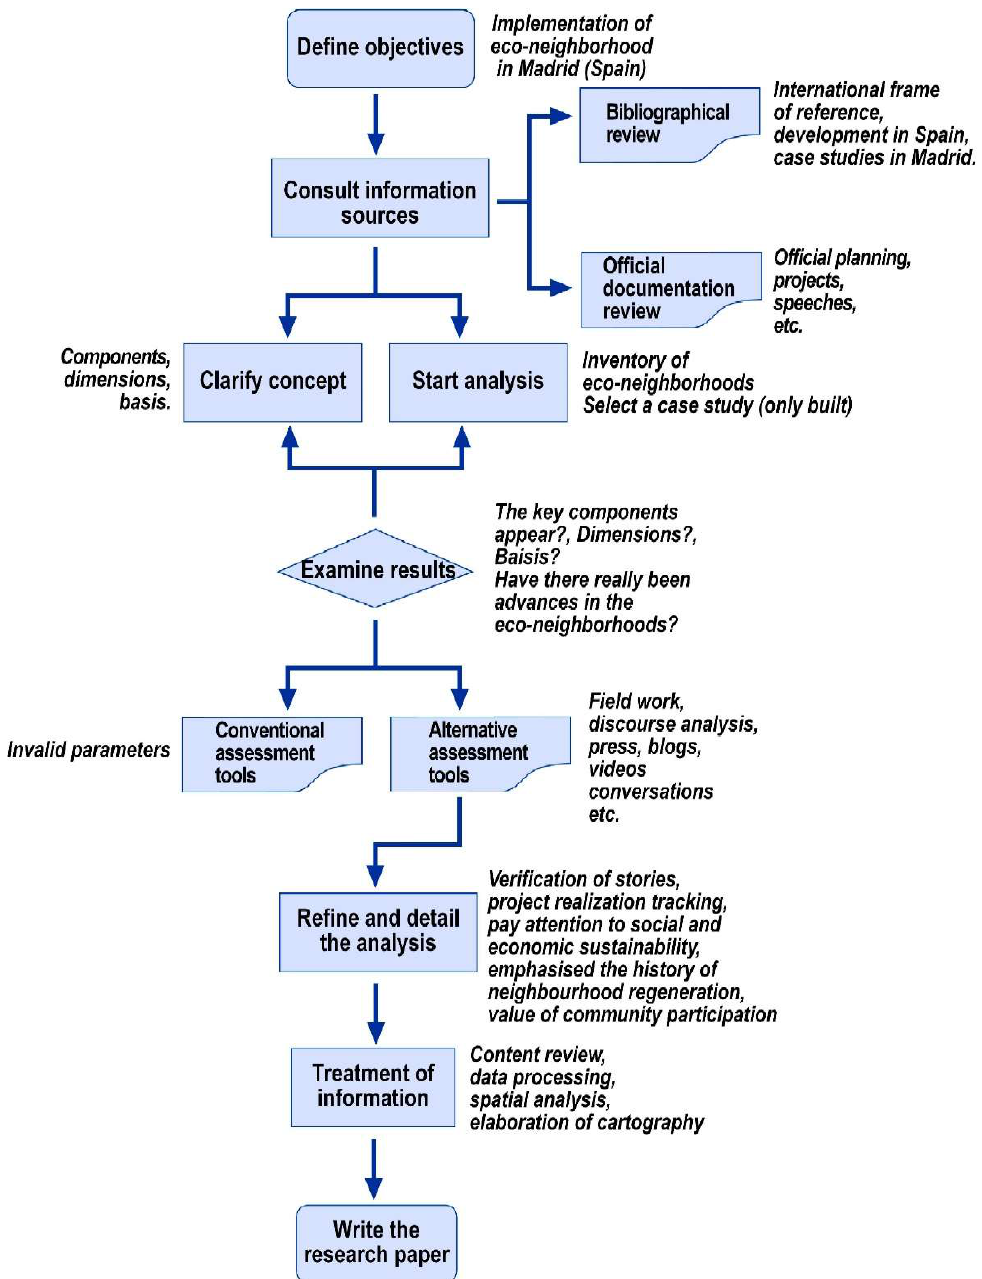
Figure 2. Flowchart of the research methodology. Source: The authors.